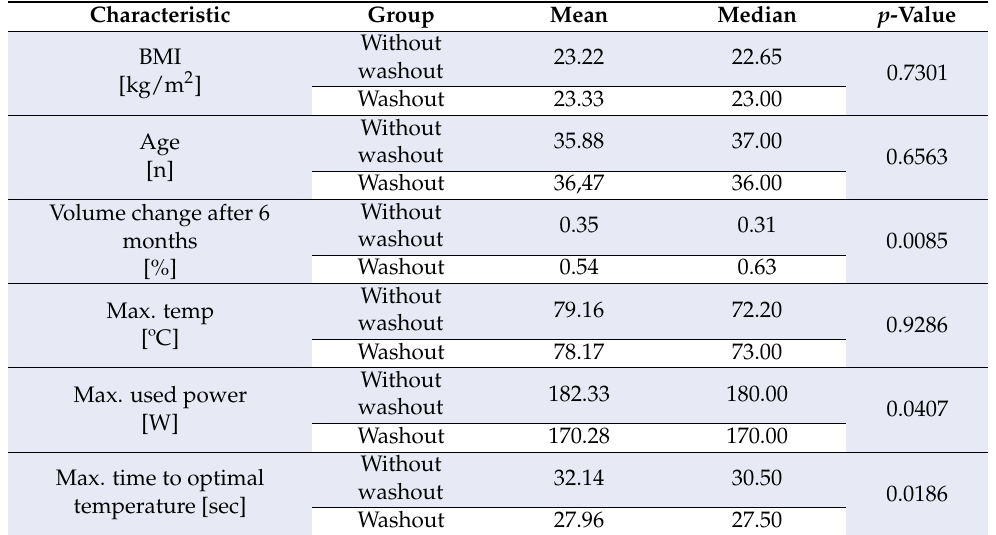
Table 7. Dependence of the type of enhancement curve with and without washout on other patient characteristics and treatment parameters.